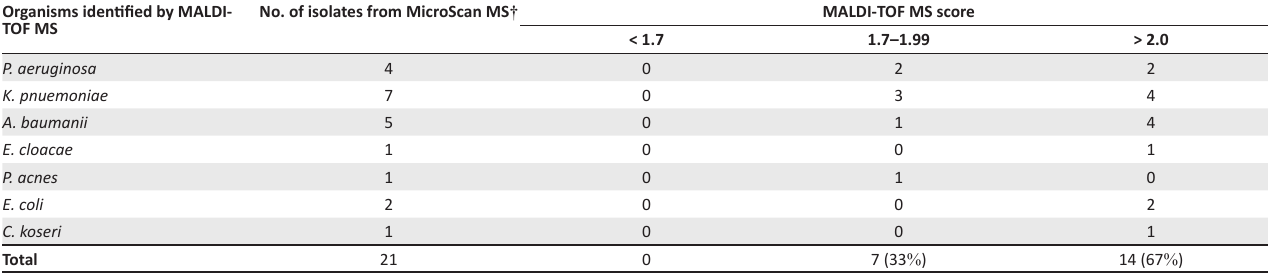
TABLE 4: Gram-negative bacteria identified directly from blood cultures by MALDI-TOF MS ( N = 21), Bloemfontein, South Africa, 15 July 2013 to 30 September 2013. Organisms identified by MALDI- TOF MS